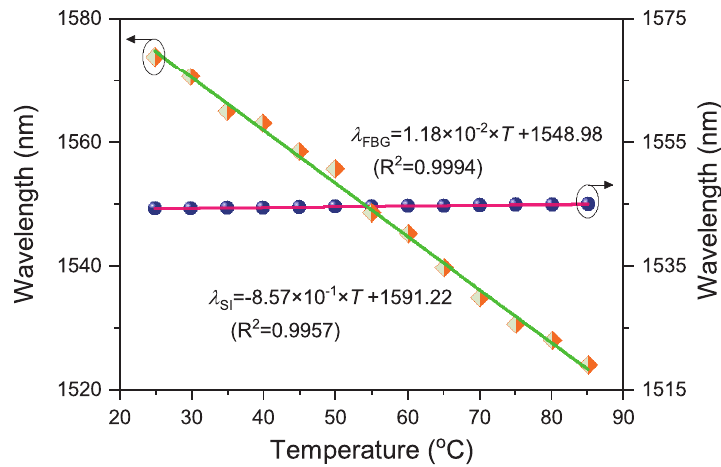
Figure 9. Thermal responses of the Sagnac interference dip (orange square with green line) and the Bragg peak of fast-axis polarized mode (blue sphere with red